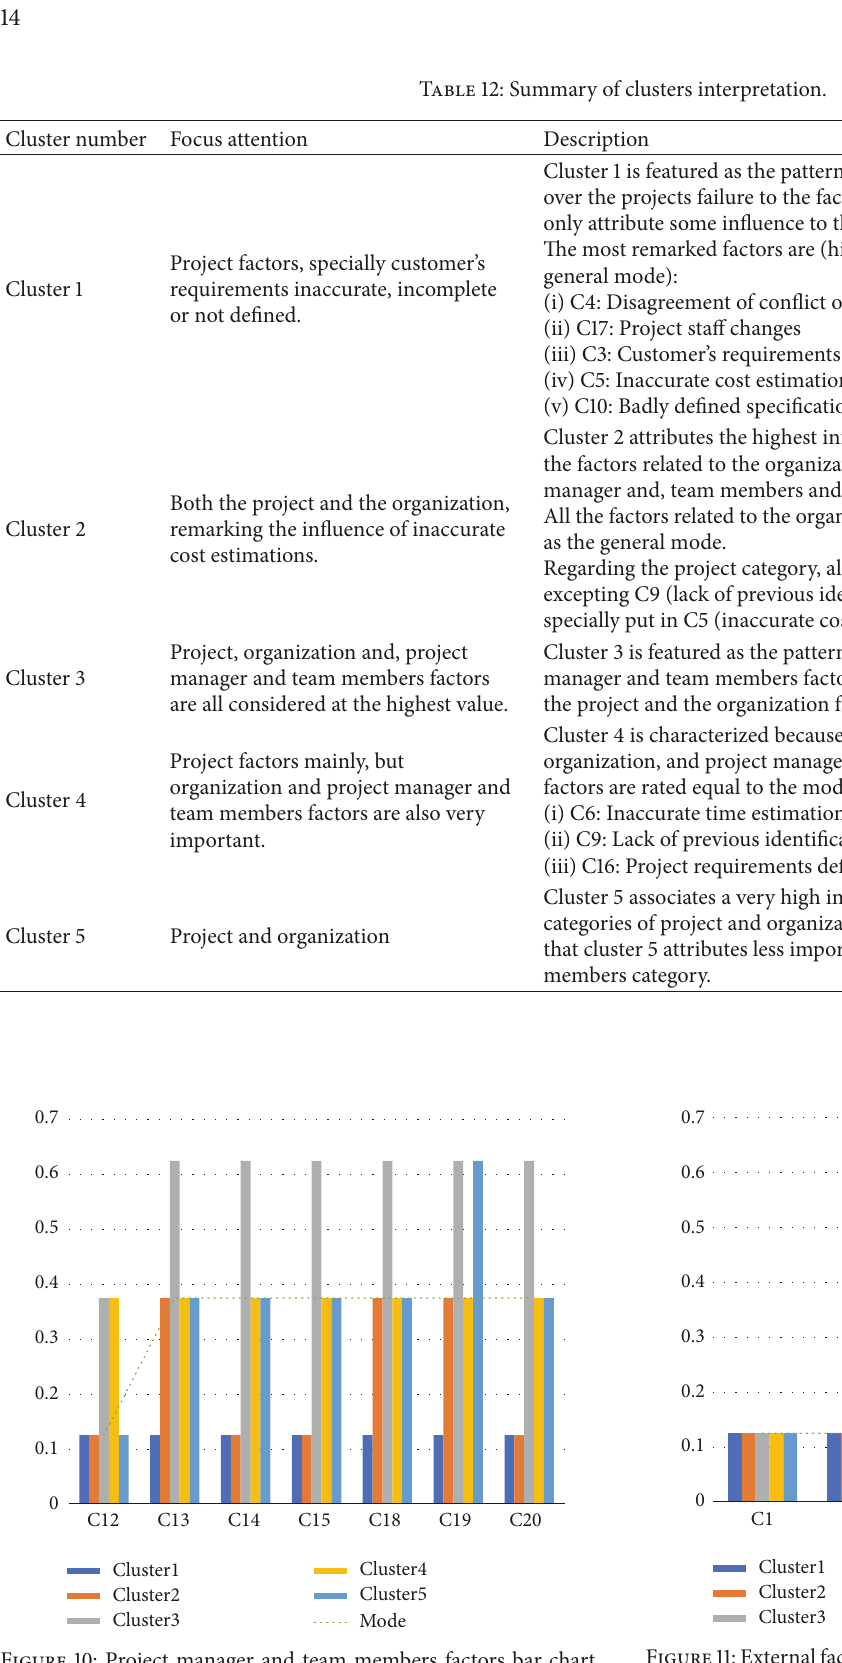
Figure 10: Project manager and team members factors bar chart. Factor importance average score of each cluster plotted against the mode of the global survey.